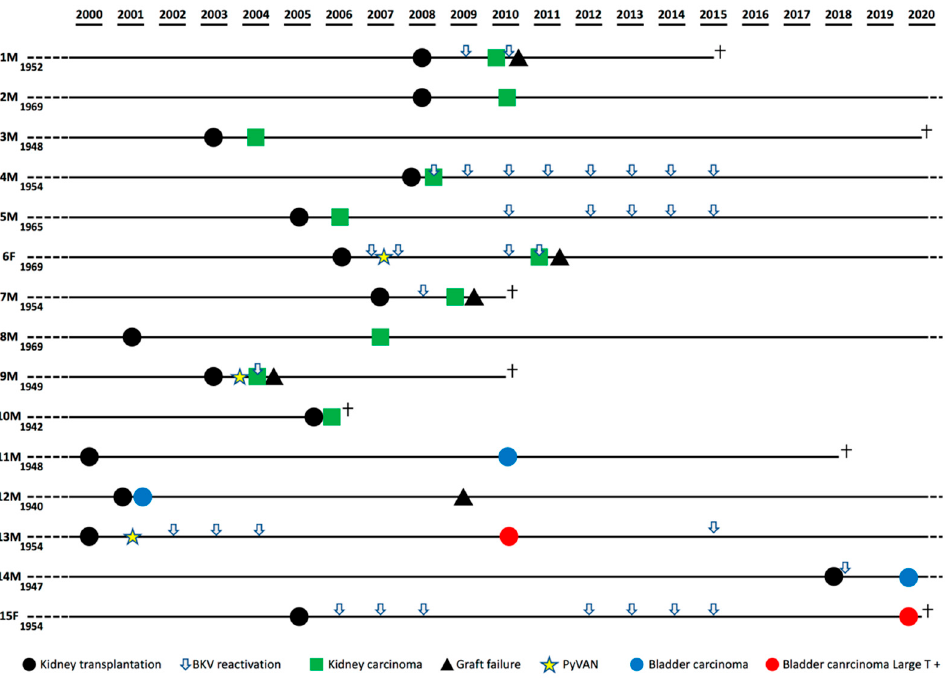
Figure 1. Patients’ clinical history timelines highlighting BK polyomavirus (BKPyV)